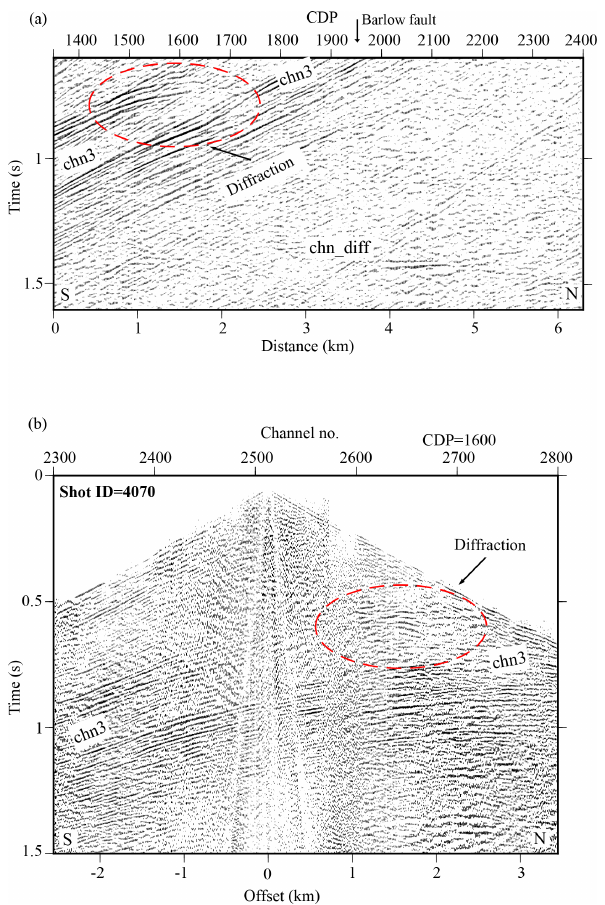
Figure 10. (a) A zoomed view from Fig. 8c (DMO stacked section with no cross-dip element applied) around the diffraction imaged. (b) Shot 4070 (see Fig. 4 for the location) acquired for the north survey, which shows the signal from the diffraction around CDP 1600 in (a) . The location of CDP 1600 is shown in (b) . See text for interpretation.